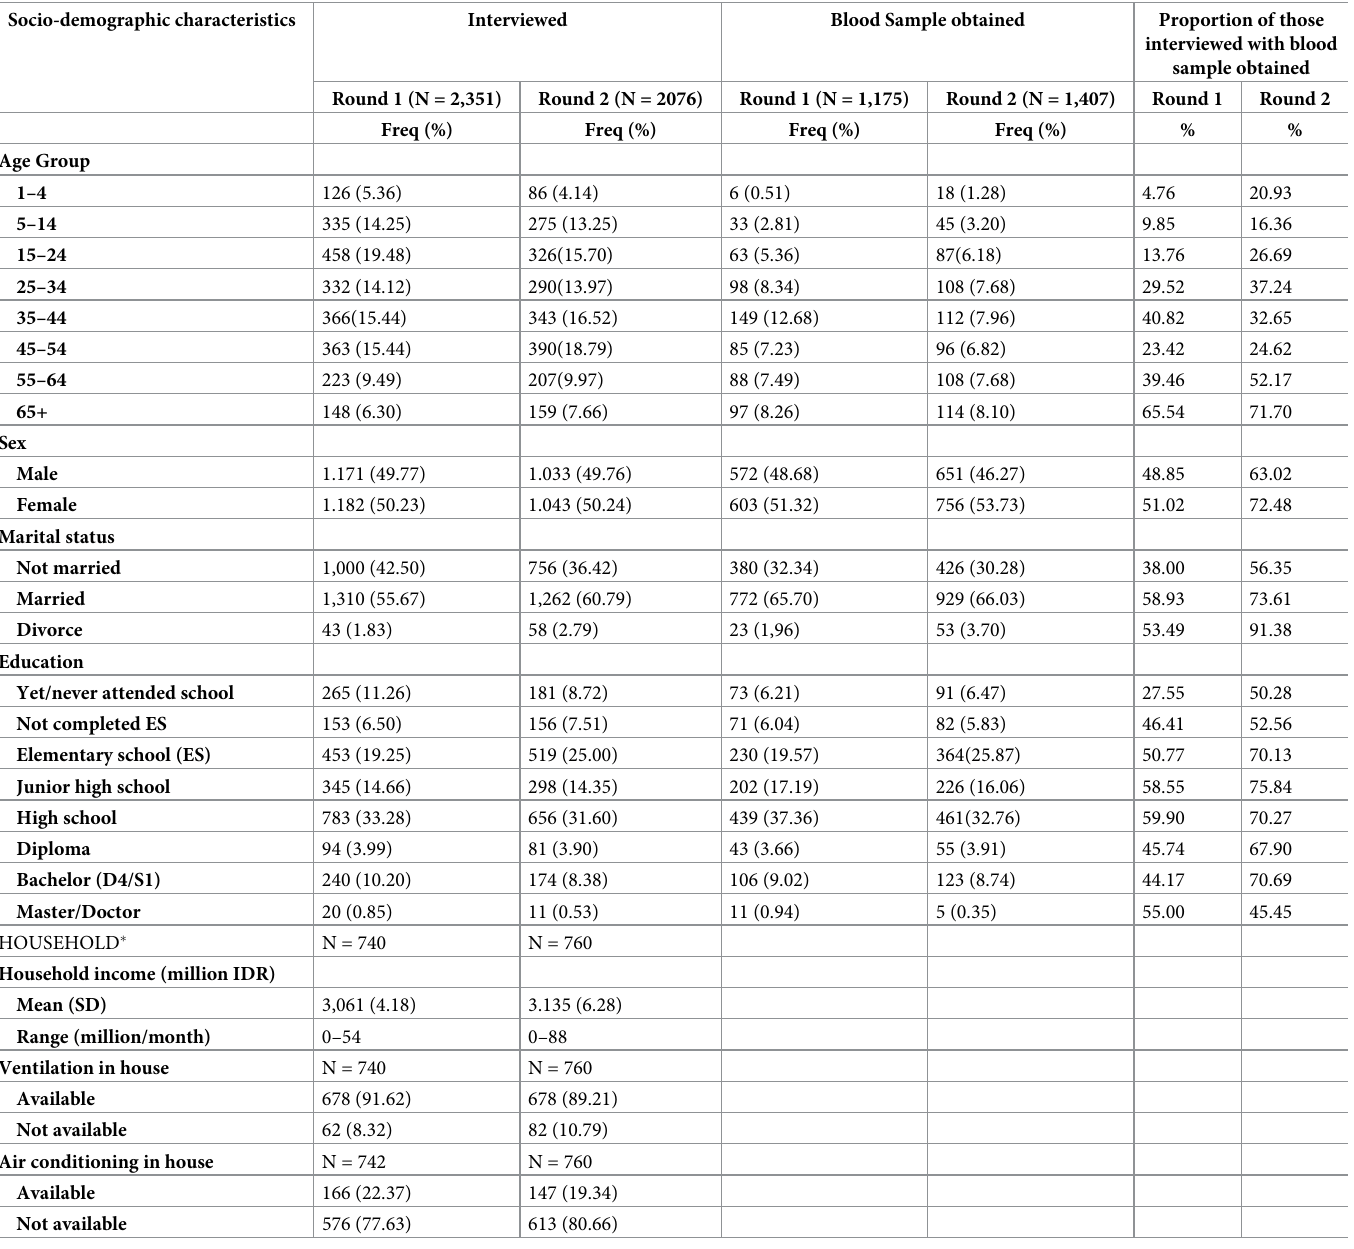
Table 2. Characteristics of survey